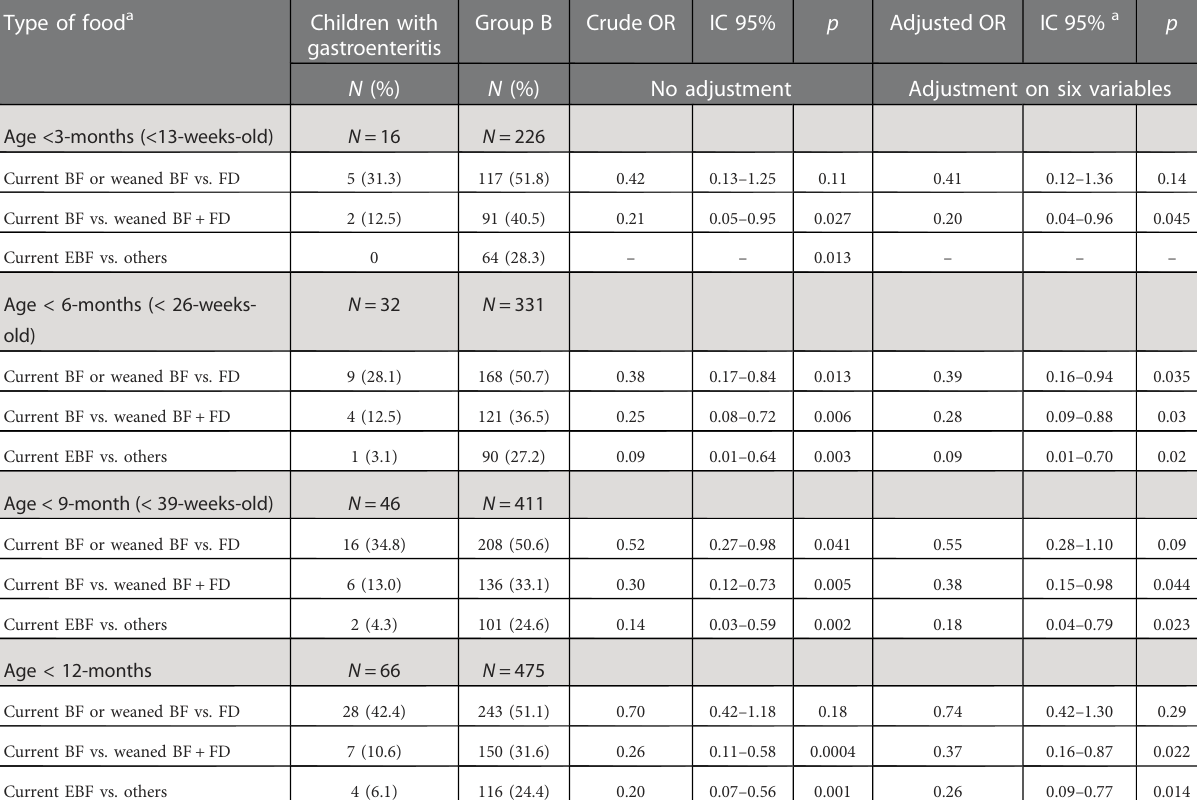
TABLE 5 Comparison between children affected by gastroenteritis and non-infected children or group B ( n =67 vs. 497) - Multivariate analysis (multiple logistic